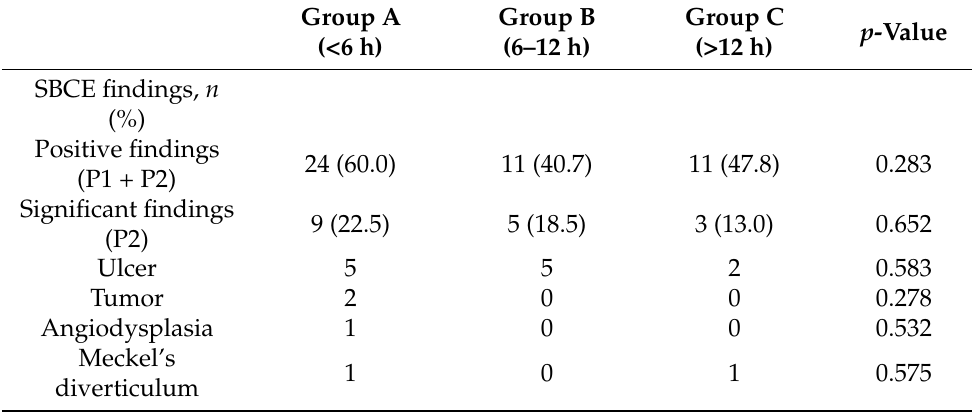
Table 3. Small bowel capsule endoscopy (SBCE) finding and diagnostic